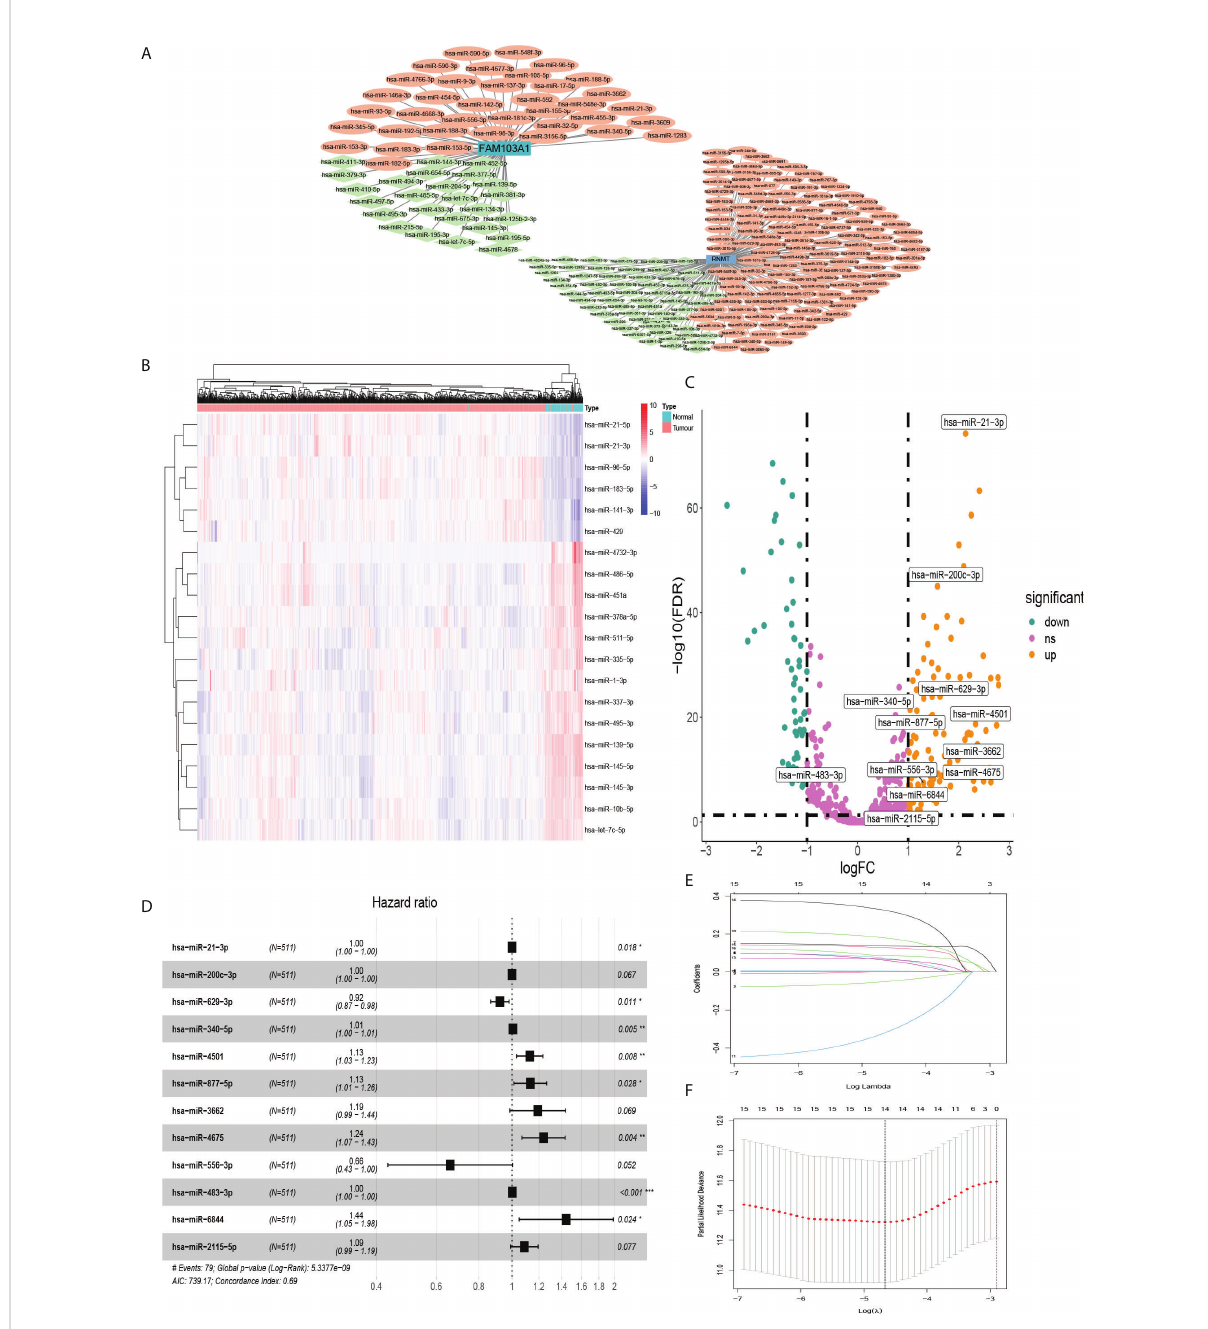
FIGURE 2 MiRNAs that were differentially expressed in BC and affected prognosis. (A) Co-expression network of RNMT/FAM103A1 and their upstream miRNAs. (B) Amongthe201upstreammiRNAsofRNMT/FAM103A1thatcangeneticallymodifybym7G,aheatmapofthetop20mostdifferentially expressedmiRNAsinBCpatientsandhealthypatientswasdrawn.Bluerepresentsthehealthypatients,andorangerepresentsBCpatients. (C) Volcanoplot ofmiRNAs. (D) AftermultivariateCoxregression,aforestplotof12miRNAs. (E,F) PlotsforLASSOregressioncoef fi